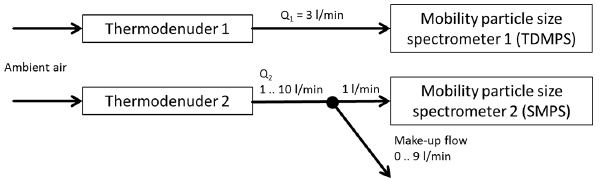
Figure A1. Experimental setup to test the sensitivity of the thermodenuder efficiency as a function of residence time.